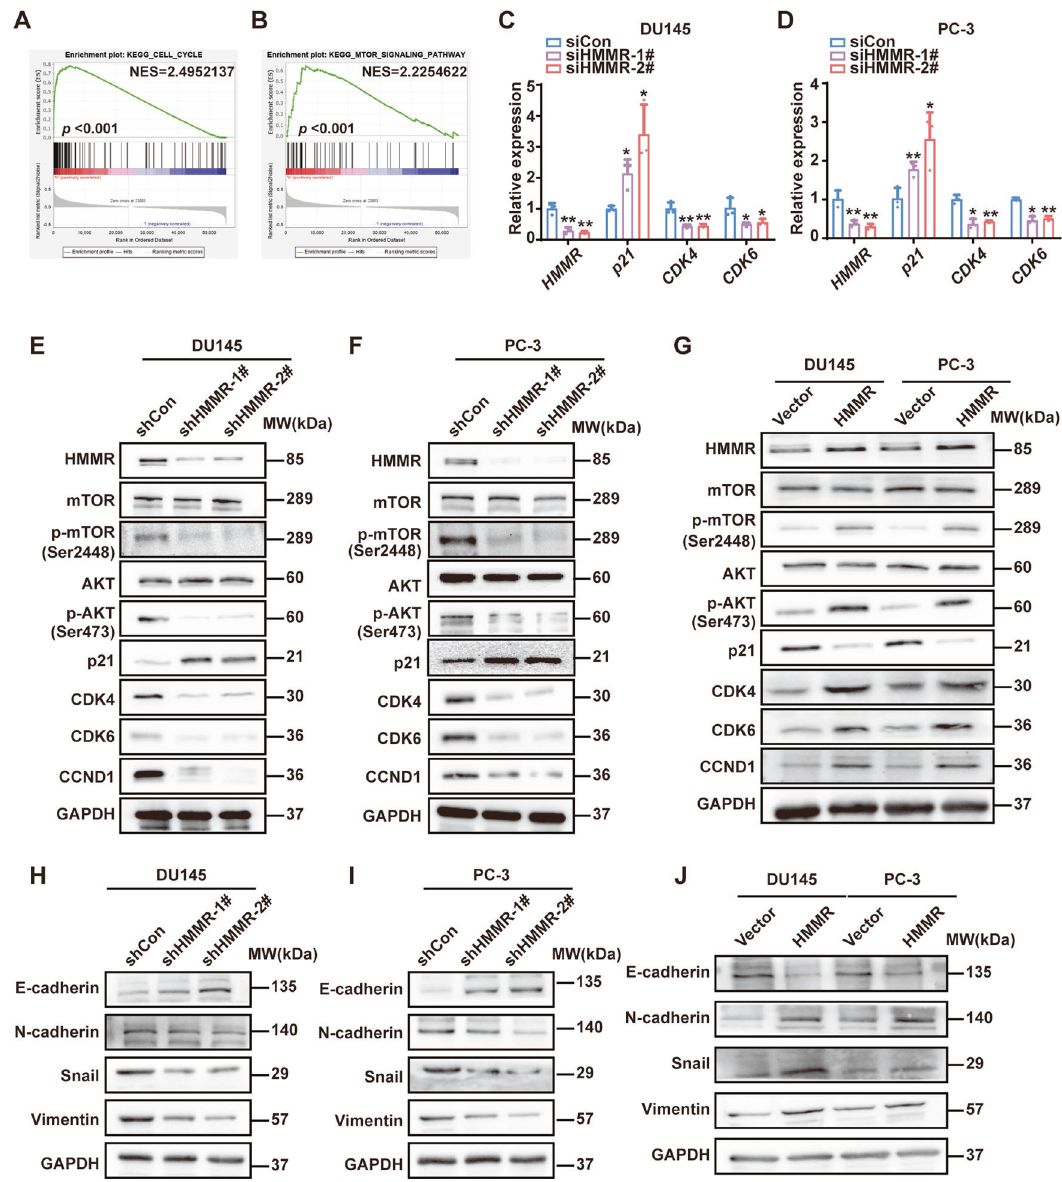
Fig. 3 HMMR promoted the activation of the mTOR/AKT pathway. A , B GSEA analysis of the pathway in which HMMR might be involved ( A : cell cycle; B : mTOR pathway). C , D qRT – PCR analysis of cell cycle-related proteins (P21, CDK4 and CDK6) in DU145 ( C ) and PC-3 ( D ) cells after transfection with siCon and siHMMR (#1, #2). E , F Western blotting analysis of crucial mTOR markers and downstream targets in DU145 ( E ) and PC-3 ( F ) cells after stable HMMR silencing (shHMMR-1#, shHMMR-2#). shCon was used as a negative control. G Western blotting analysis of mTOR pathway and downstream targets in DU145 and PC-3 cells after HMMR overexpression. H , I Analysis of EMT markers in DU145 ( H ) and PC-3 ( I ) cells with HMMR silencing. J Analysis of EMT markers in DU145 and PC-3 cells overexpressing HMMR. Data were presented as mean ± SD. * p < 0.05, ** p <